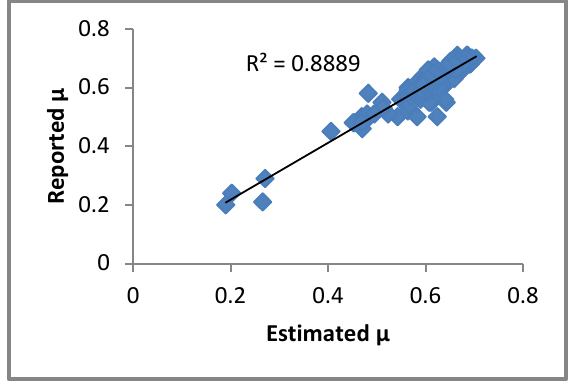
Figure 6. Correlation between experimental and predicted values from ANFIS in test data internal friction coefficient (µ).